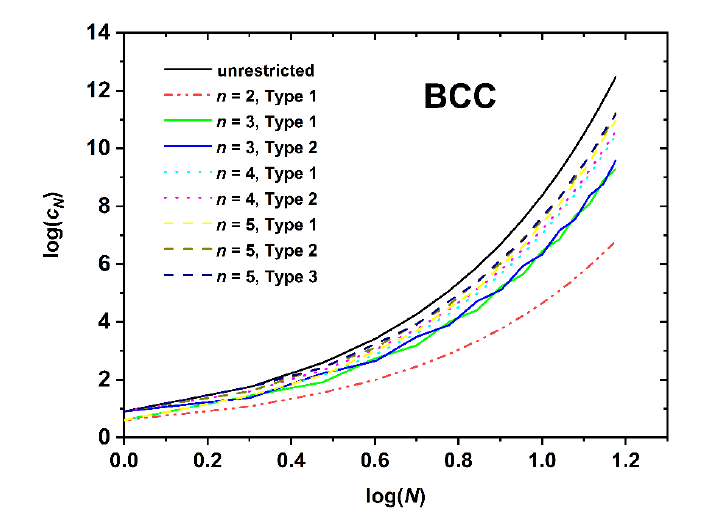
Figure 6. Logarithm of the number of distinct SAWs, c N , versus the logarithm of the number of SAW steps, N , as obtained from direct enumeration on the BCC lattice under plate-like confinement.